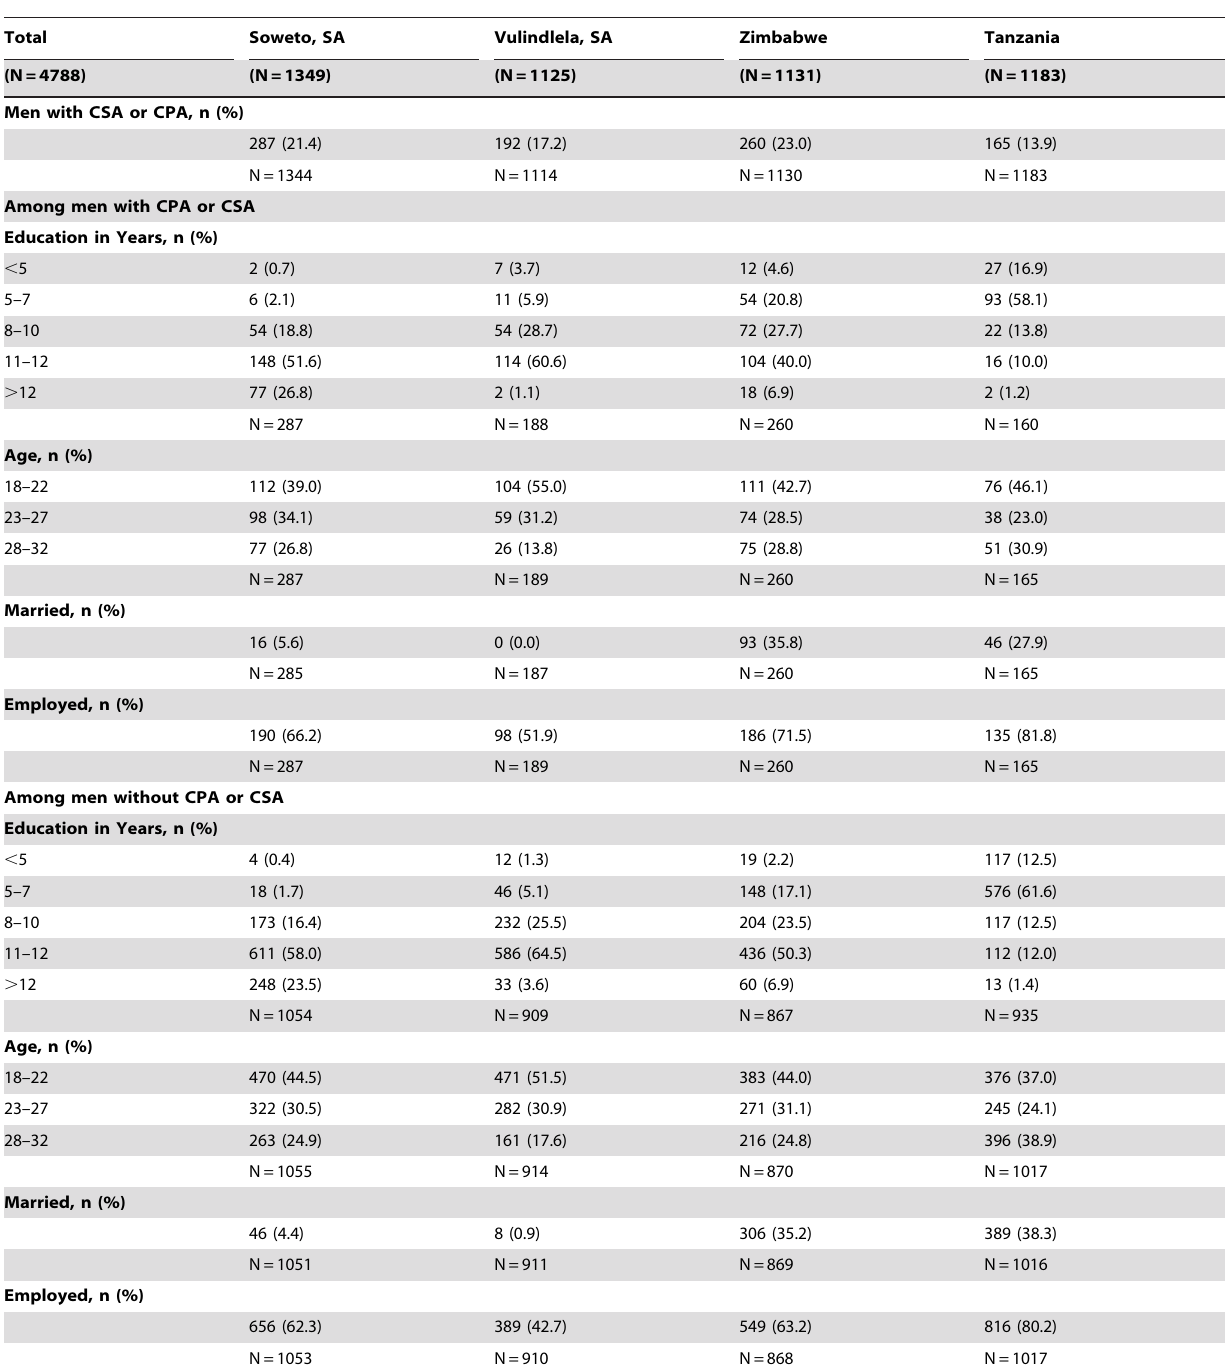
Table 1. Demographic characteristics among men at post-intervention